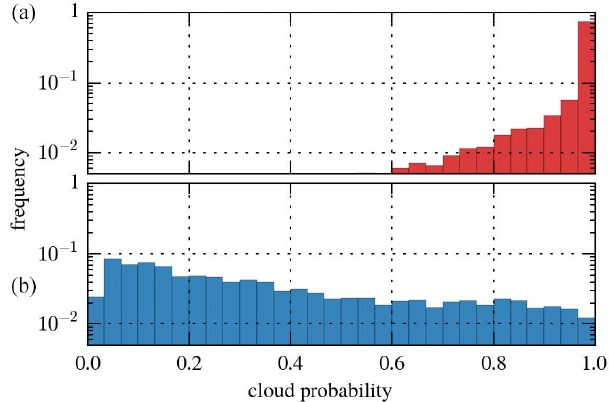
Figure 5. Distribution of MECOSI cloud probability for AATSR cloud pixels (a) and AATSR clear-sky pixels (b) for May to Septem- ber 2009.